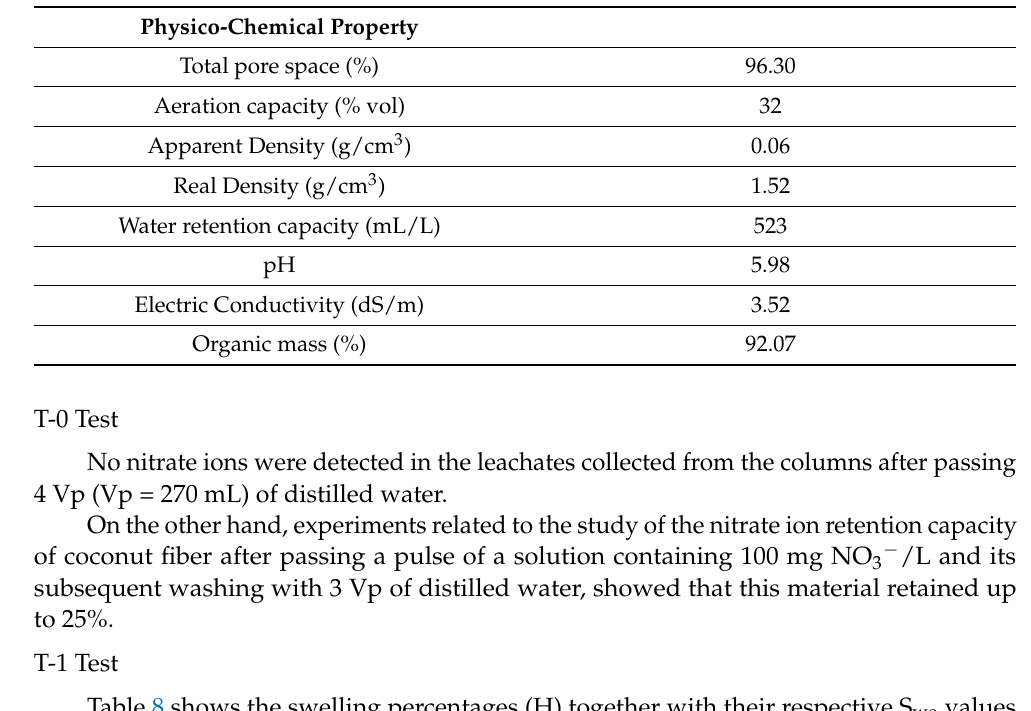
Table 7. Coconut fiber physico-chemical properties.